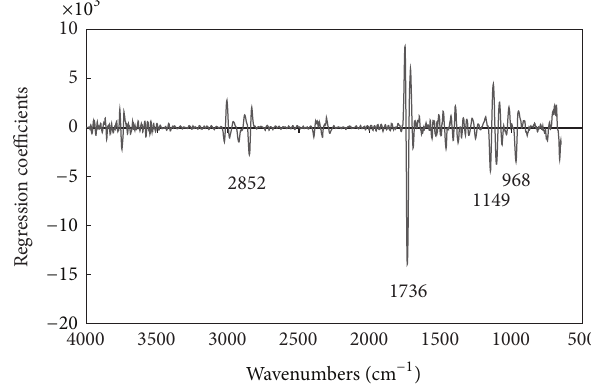
Figure 6: Regression coefficients of the PLS calibration model for TPC based on the second derivative